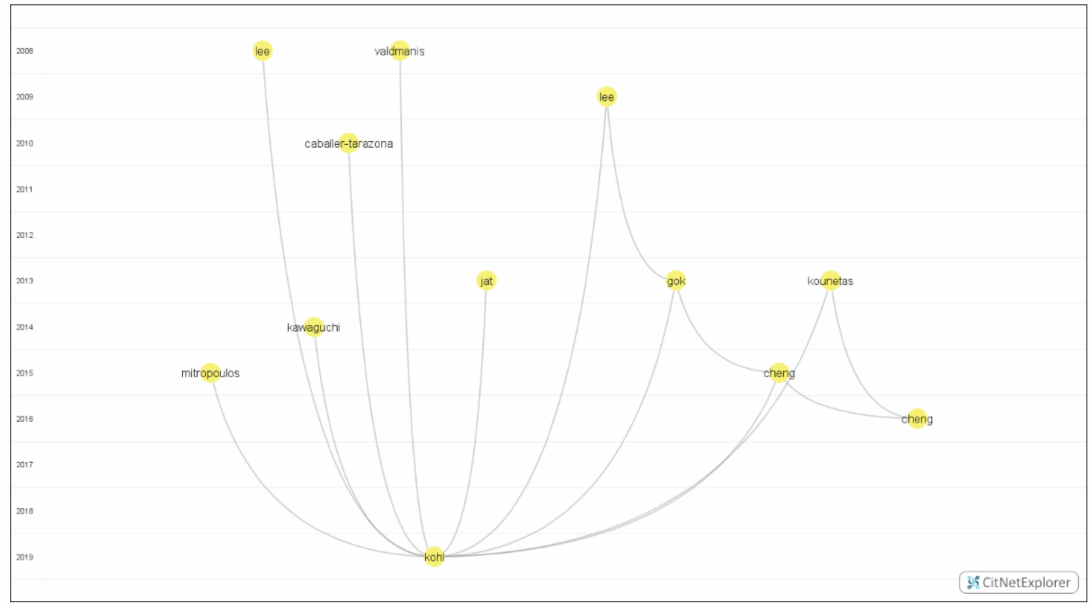
Figure 4. Timeline-based network visualization for the most relevant